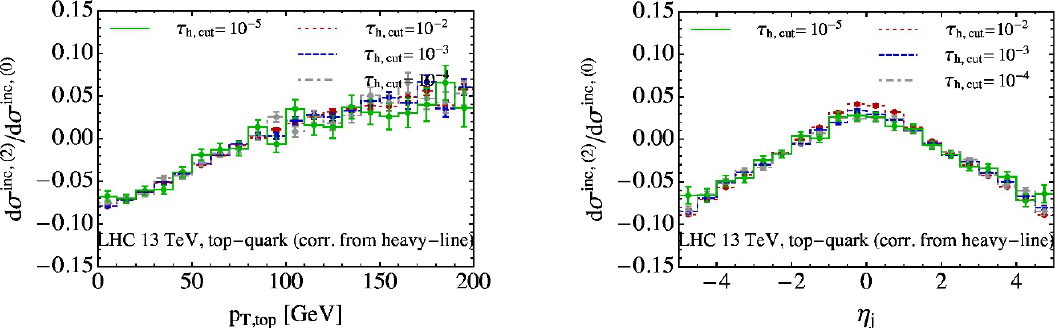
Figure 9 . NNLO corrections from the heavy-quark line for the transverse momentum distribution of the top quark (left), and the pseudorapidity distribution of the leading jet (right), for top-quark production at 13 TeV, with di(cid:11)erent choices of the cut-o(cid:11). not change the total event rate in our numerical calculation, as expected from eq.